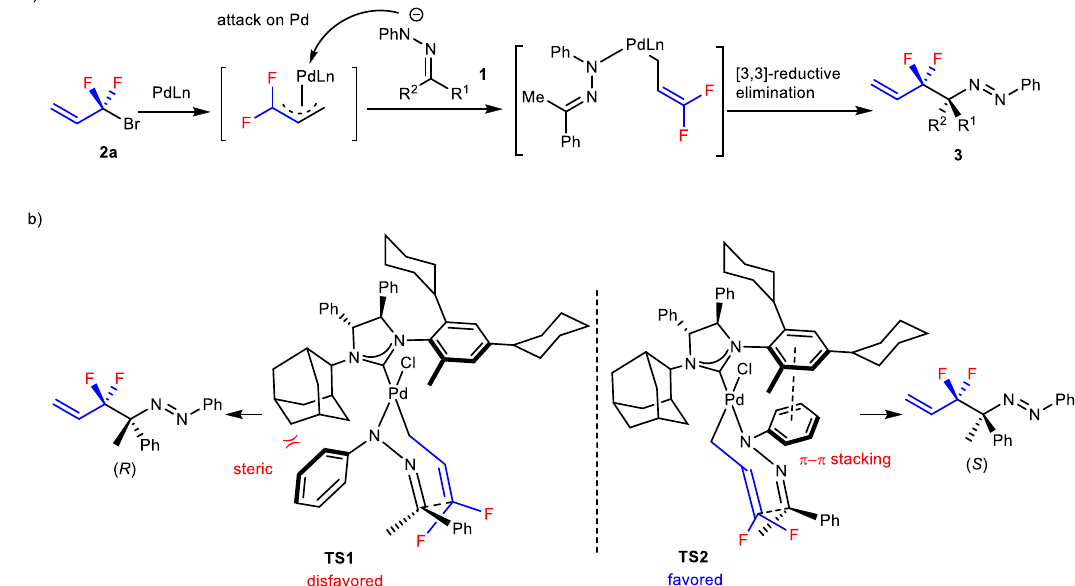
Fig. 9 Proposed reaction mechanism. a Inner-sphere process for the formation of 3 . b Proposed transition states of the reaction.